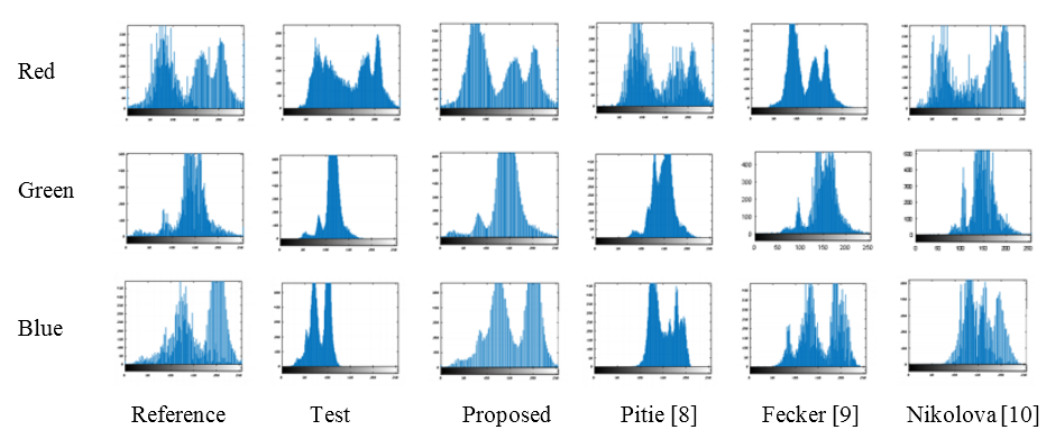
histograms (three color channels, respectively) of overlapping regions in the reference image, the corresponding histograms of overlapping regions after the proposed method, the fourth column